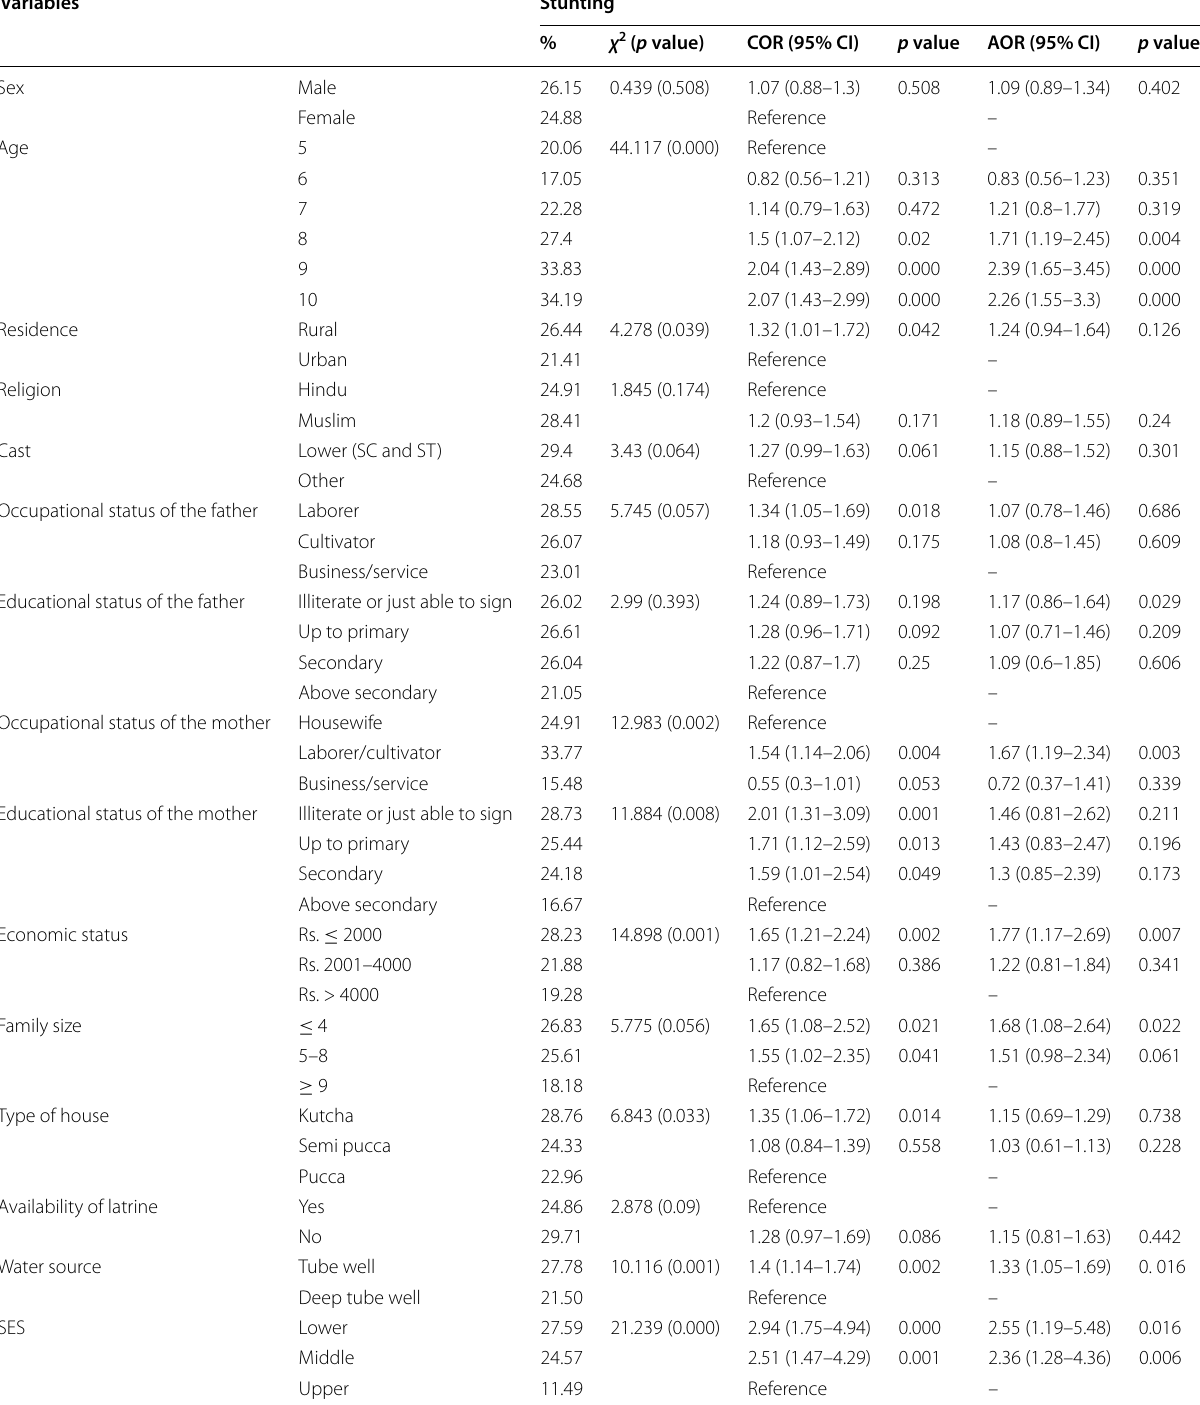
Table 3 Factors associated with stunting among children aged 5–10 years